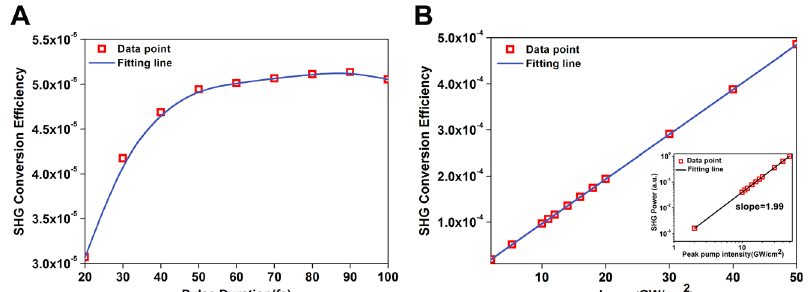
Figure 8: Optimizing calculations of the pump light conditions. (Color online) (A) SHG conversion efficiency versus different pump light pulse duration. (B) SHG conversion efficiency as a function of pump light peak intensity varying from 2 to 50 GW/cm 2 . The inset shows the log – log plot of quadratic dependence of the SHG power on the peak pump intensity at 565.4 nm fundamental wavelength.A fi ttothisdataproducesablack linewithaslopeof1.99,whichisverycloseto the theoretical prediction of two reasonably well.